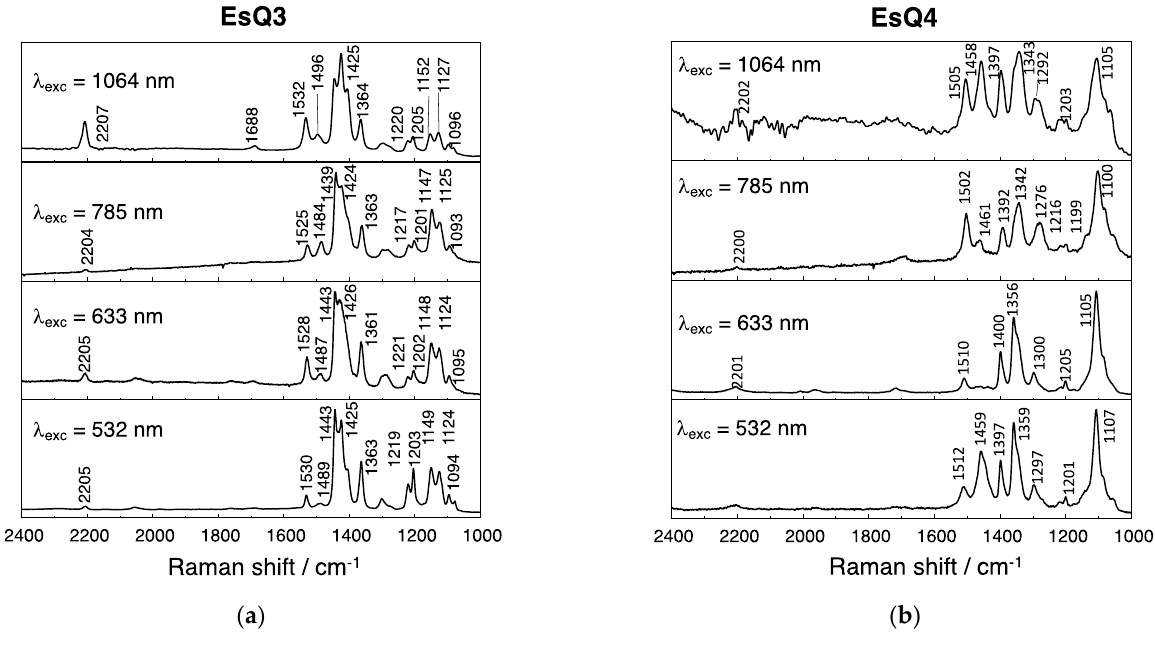
Figure 7. Raman spectra of EsQ3 ( a ) and EsQ4 ( b ) measured in the solid state at room temperature with different excitation wavelengths: from top to bottom: 1064 nm; 785 nm; 633 nm; 532 nm.